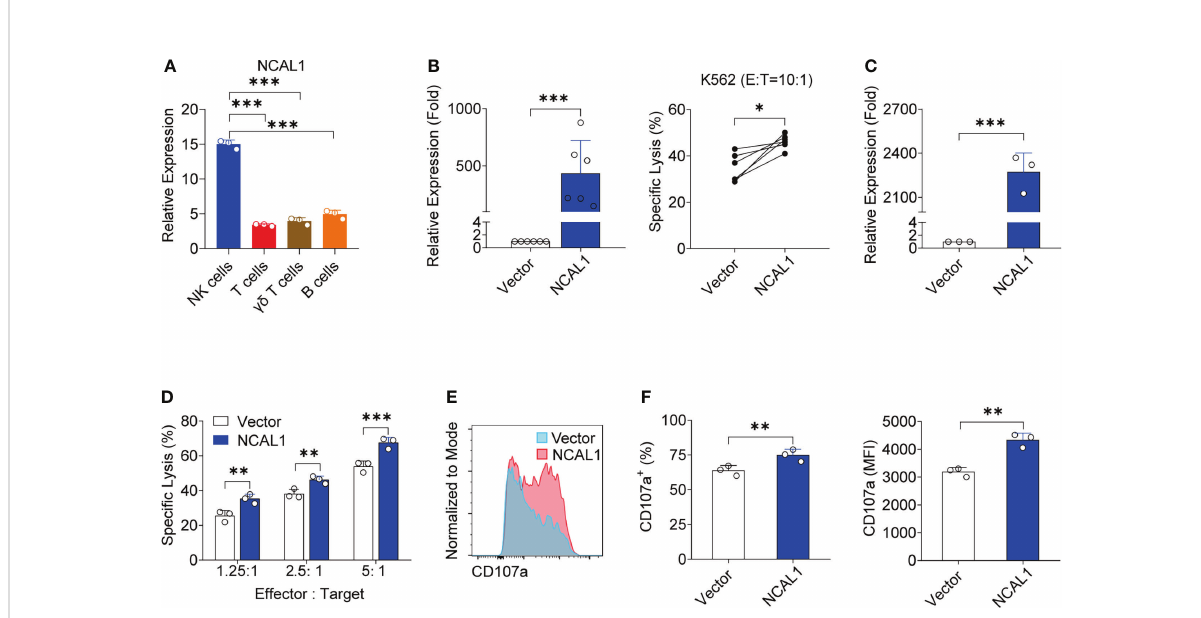
FIGURE 1 NCAL1 is a novel lncRNA that enhances NK cell cytotoxicity. (A) NCAL1 is highly expressed in NK cells. Relative mRNA expression of NCAL1 in human primary NK cells, T cells, gd T cells, and B cells. Data represent three independent experiments. *** p < 0.001, one-way ANOVA. (B) NCAL1 overexpression increases the killing effect of primary NK cells (left panel). Primary NK cells were transfected with NCAL1-overexpressing lentivirus and control vector lentivirus for 48 h. After GFP-positive cell selection, stable cells were collected for qPCR analysis. n = 6, *** p < 0.001, two-tailed paired t -test. The right panel shows cytotoxicity following NCAL1 overexpression in primary NK cells, as detected via calcein-release assays. n = 6, * p < 0.05, two-tailed paired t -test. (C) NCAL1 overexpression in NK92MI cells. NK92MI cells were transfected with NCAL1-overexpressing lentivirus and control vector lentivirus. After GFP-positive cell selection, stable cells were collected for qPCR analysis. *** p < 0.001, two-tailed paired t -test. (D) Cytotoxicity of NK92MI cells overexpressing NCAL1 at various effector cell:target cell ratios, as detected by calcein-release assays. Data represent three independent experiments. ** p < 0.01, *** p < 0.001, two-way ANOVA. (E) Representative fl ow cytometry analysis of CD107a expression in NCAL1-overexpressing NK92MI cells. (F) CD107a + cell percentages and mean fl uorescence intensity (MFI) indicating the CD107a expression in NCAL1-overexpressing NK92MI cells. Data represent three independent experiments. ** p < 0.01, two-tailed paired t